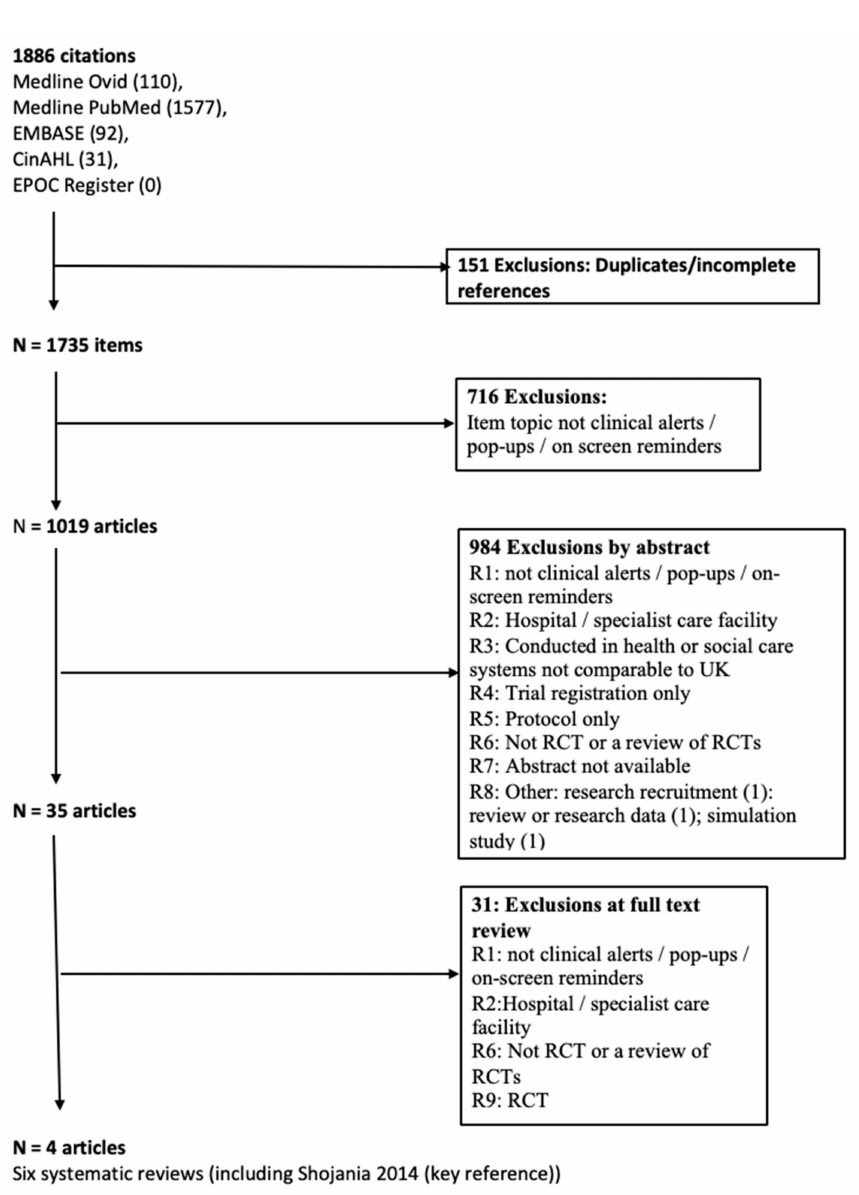
Figure A2. Flow chart for the rapid review of factors facilitating the impact of clinical system alerts on clinical